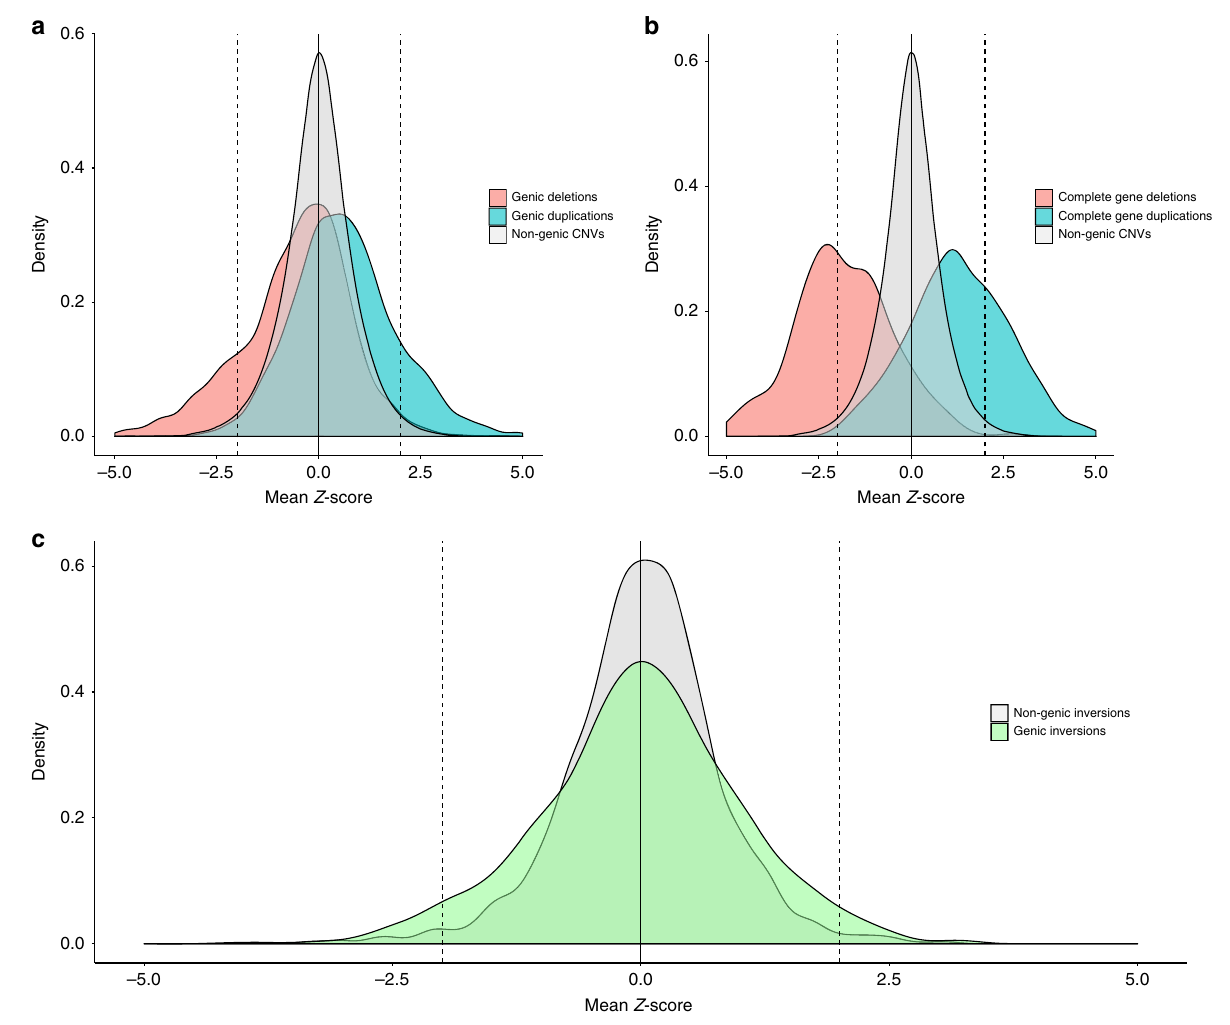
Fig. 3 Genic SVs induce observable changes in expression. Expression presented as a z -score for a all CNV that overlap any proportion of the exonic sequence of a gene, b CNV that delete or duplicate 100% of the exonic sequence of a gene, and c all inversions with any gene overlap (green) compared to all other SVs (gray). Deletions are red, duplications are blue. The dashed lines are located at z -score of 2 and −